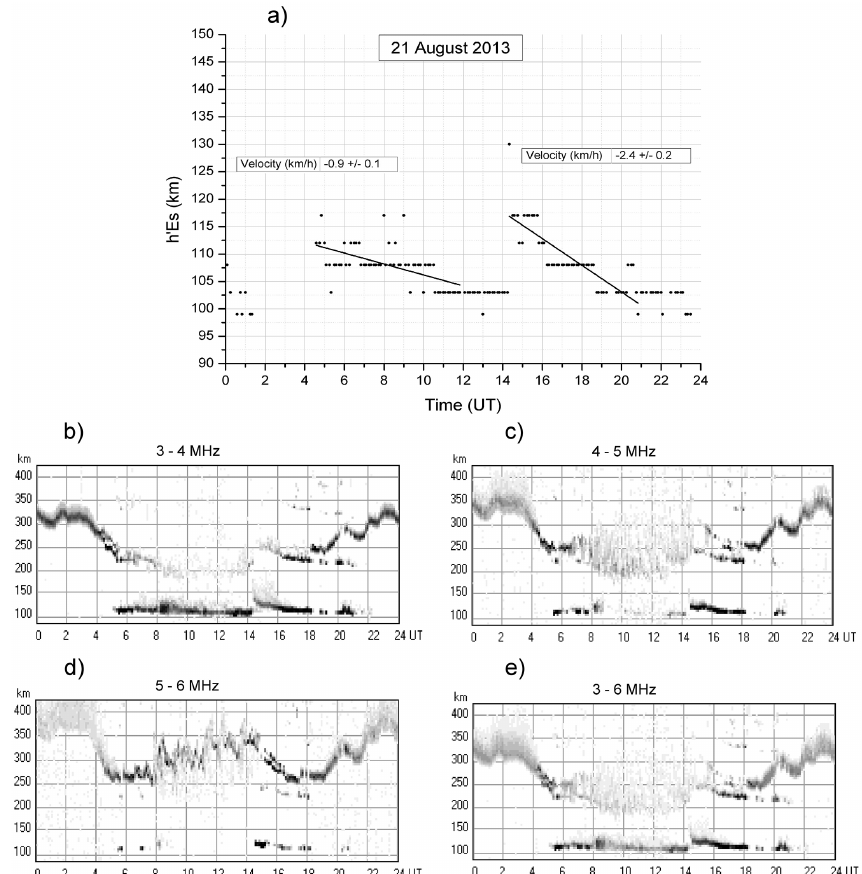
Figure 8. (a) h’Es values manually validated for the 21 August 2013, with the corresponding linear fits, and the HTI plots generated for the same day for different frequency ranges: (b) 3–4MHz, (c) 4–5MHz, (d) 5–6MHz, and (e) 3–6MHz.